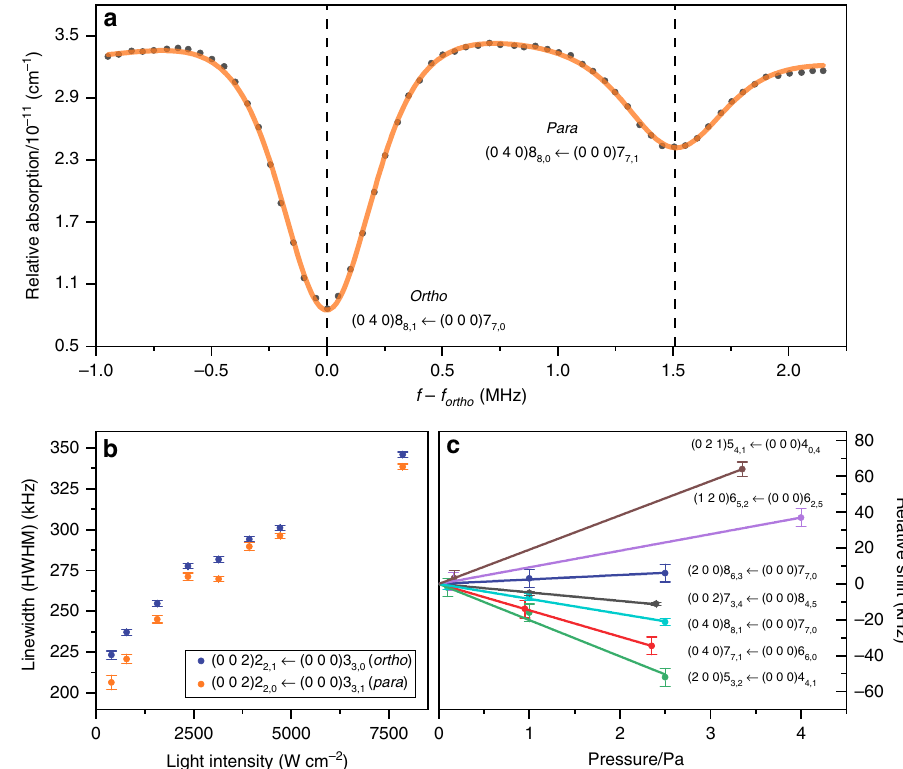
Fig. 4 Overview of the NICE-OHMS experiments performed for H 2 16 O. a NICE-OHMS spectrum of the (0 4 0)8 8,1/0 ← (0 0 0)7 7,0/1 doublet. The scanning frequency, f , is shifted with the line position of the ortho transition, f ortho = 218,444,703.636 MHz (separated by 1.5 MHz from the para line). As clear from this spectral recording, the ortho line exhibits a three times larger intensity than its para counterpart, which is due to the nuclear-spin degeneracy factors and the nearly equal Einstein A coef fi cients of the lines. Note that the assignment of this doublet is interchanged in HITRAN2016 1 . b Measured linewidth (half width at half maximum, HWHM) of the saturated resonance as a function of intracavity intensity for the (0 0 2)2 2,1/0 ← (0 0 0)3 3,0/1 ortho – para doublet. The pressure-free wavenumbers of these two lines are determined to be 7286.715 825 626(60) ( ortho ) and 7285.044 729 204(63) cm − 1 ( para ). c Pressure-shift study of the saturated absorption line centers for some H 2 16 O lines with their assignments. The error bars represent one standard deviation. Source data are provided as a Source Data fi le.